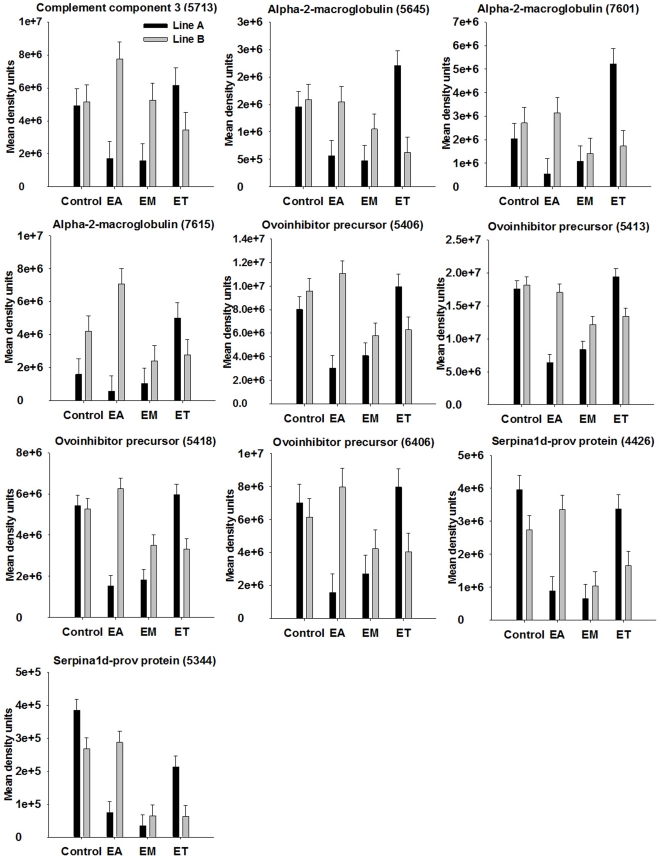
Broiler genetic line×coccidia infection interactions (P<0.001) for complement component 3 and protease inhibitors.Line A and B broiler chicks were either not infected (control) or were inoculated with 1 of 3 Eimeria species, E. acervulina (EA), E. maxima (EM) or E. tenella (ET) at 15 d post-hatch. At 21 d (6 d post-infection) serum was harvested from whole blood samples and used for 2D gel electrophoresis followed by MALDI TOF/TOF. Protein density was evaluated by densitometric analysis of spot intensity followed by ANOVA. Values represent mean density units ± SEM (N = 6).